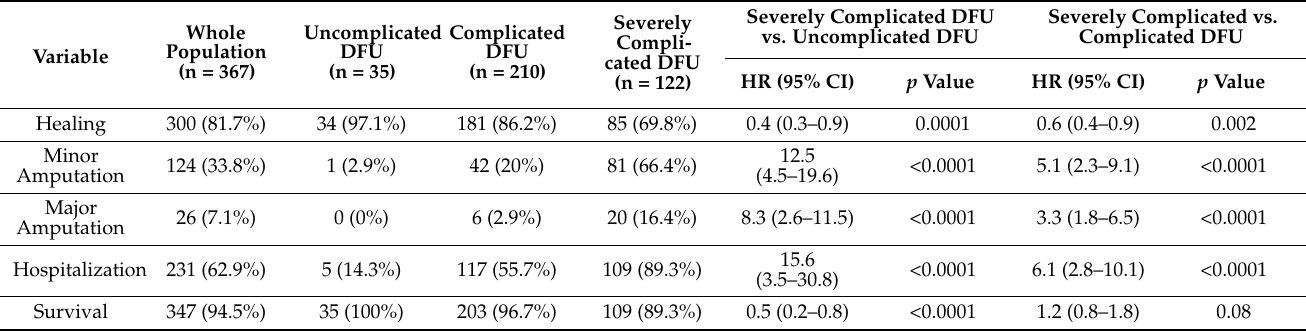
Table 3. Outcomes of interest for the whole population and for patients with uncomplicated, compli- cated, and severely complicated diabetic foot ulcers. DFU: diabetic foot